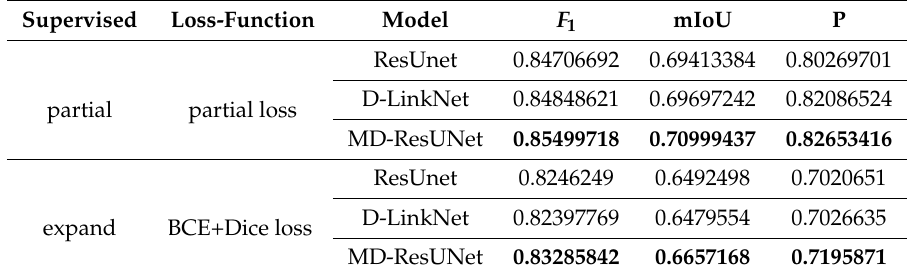
Table 4. Different performance of road extraction using different annotation with different loss functions in dataset